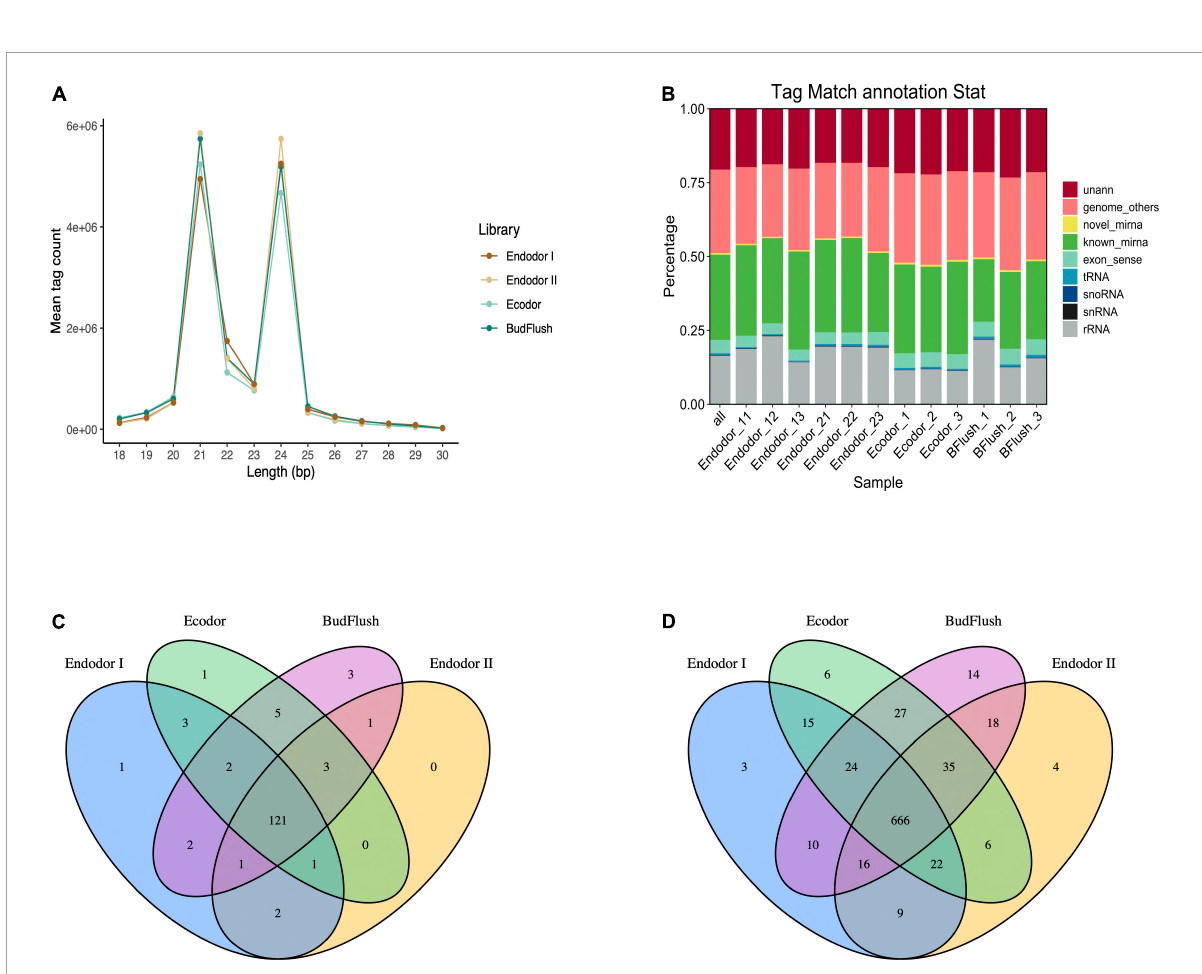
FIGURE4 Overview of small RNA sequencing analysis. (A) The size distribution of small RNAs generated across four developmental stages. (B) The annotation of clean sequence tags across 12 small RNA sequencing libraries of four developmental stages. (C,D) The Venn diagram of known miRNAs (C) and novel miRNAs (D) identified across four developmental